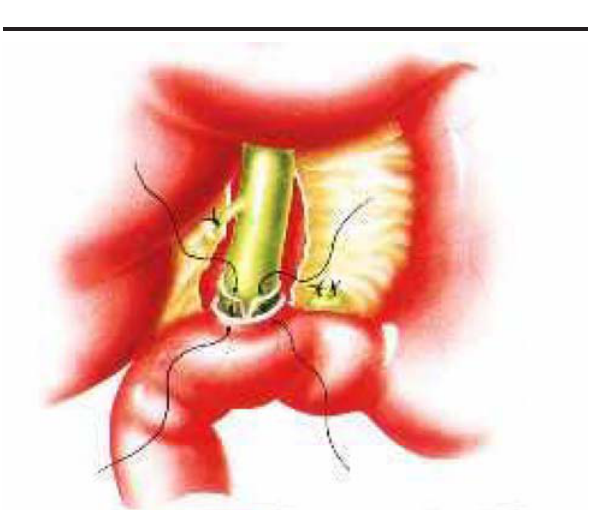
FIGURA 11 - Desenho mostra a sutura da parede anterior da eversão com a parede anterior do colédoco.